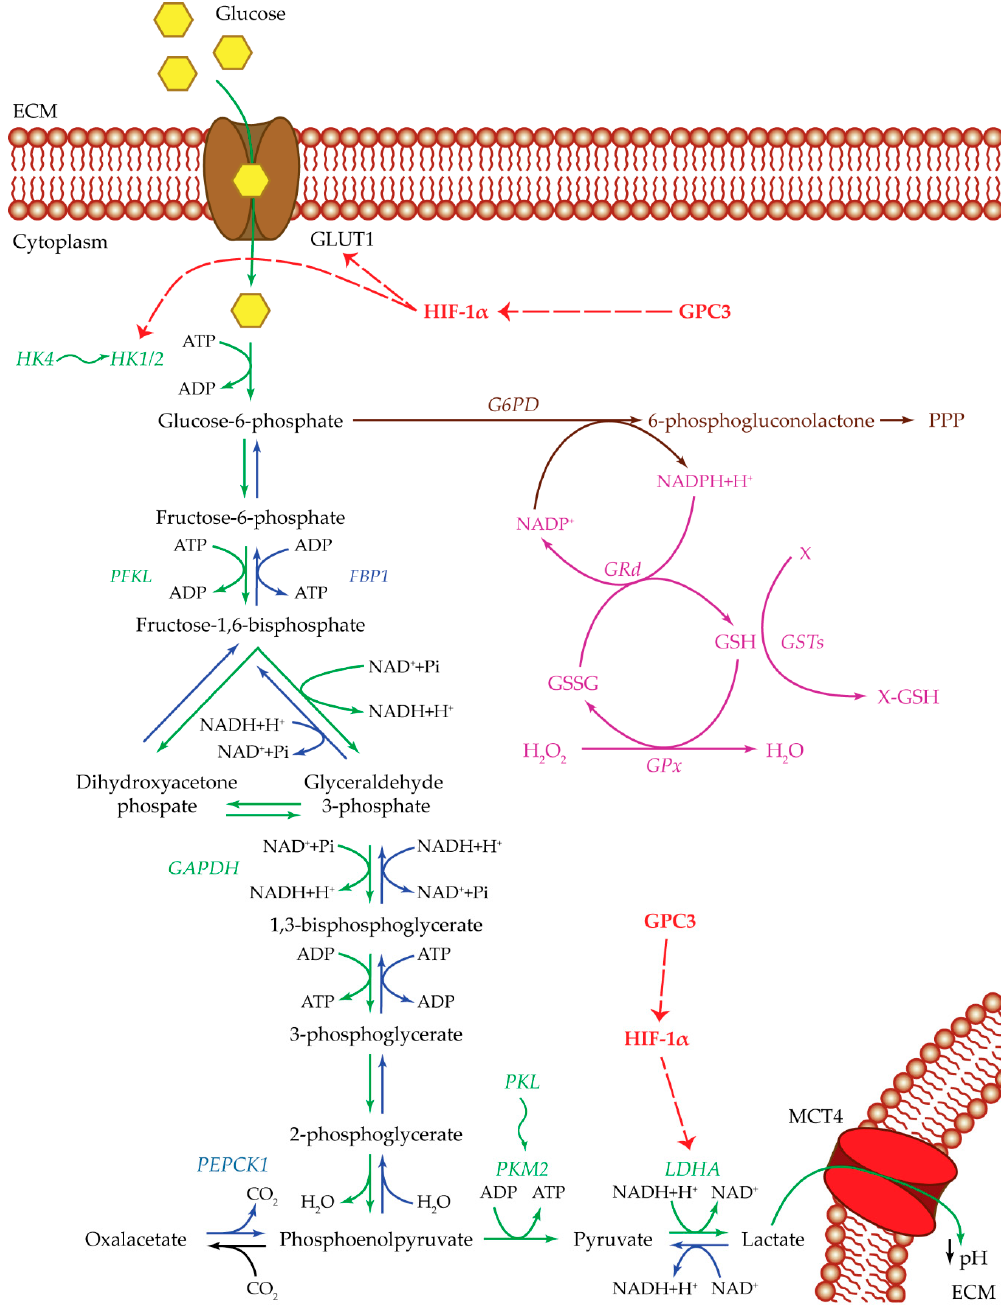
Figure 1. Glucose metabolism. Summarized are the most important players of the pathways used by cancer cells: glycolysis pathway (green), gluconeogenesis pathway (blue), pentose phosphate pathway (brown), and glutathione cycle (purple). Upregulating actions of GPC3 and HIF-1 α are visualized with a red dotted arrow. Isoenzyme switches are illustrated as wavy arrows. HCC metabolism is shifted towards anaerobic glycolysis with an increase in glucose uptake by the activity of the GLUT1 transporter. Once inside the cell, glucose is transformed into G6P by HK1/2. Both GLUT1 and HK1/2 are positively regulated by HIF-1 α , which in turn is upregulated by GPC3. In one case, G6P could be redirected towards the PPP, to produce metabolic intermediates useful for cell survival, and NADPH essential for glutathione reduction and ROS control. In the other case, G6P could continue through the anaerobic glycolytic pathway until the transformation of pyruvate into lactate by LDHA. The upregulation of LDHA enzyme is essential for the glycolytic pathway to remain active. This step could be regulated